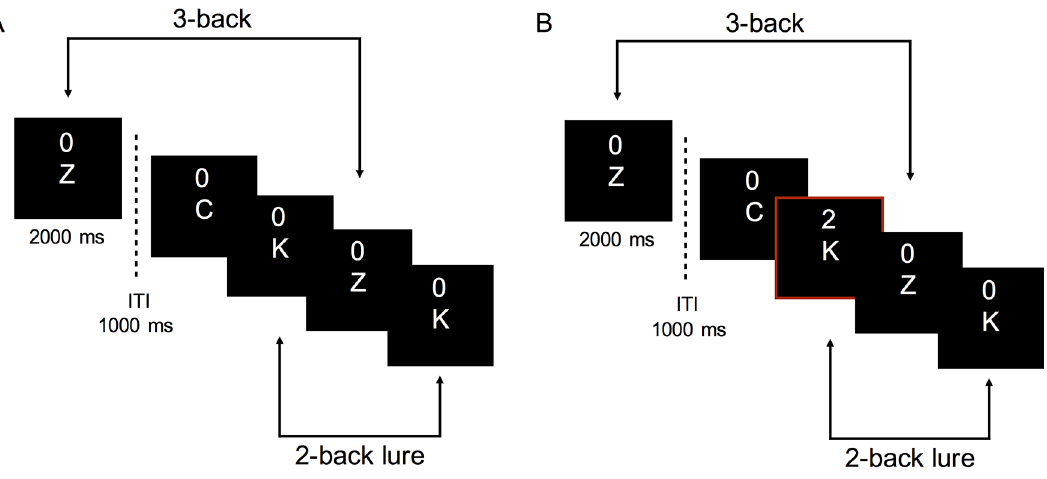
Figure 4. Trial sequence of the 3-back task for both